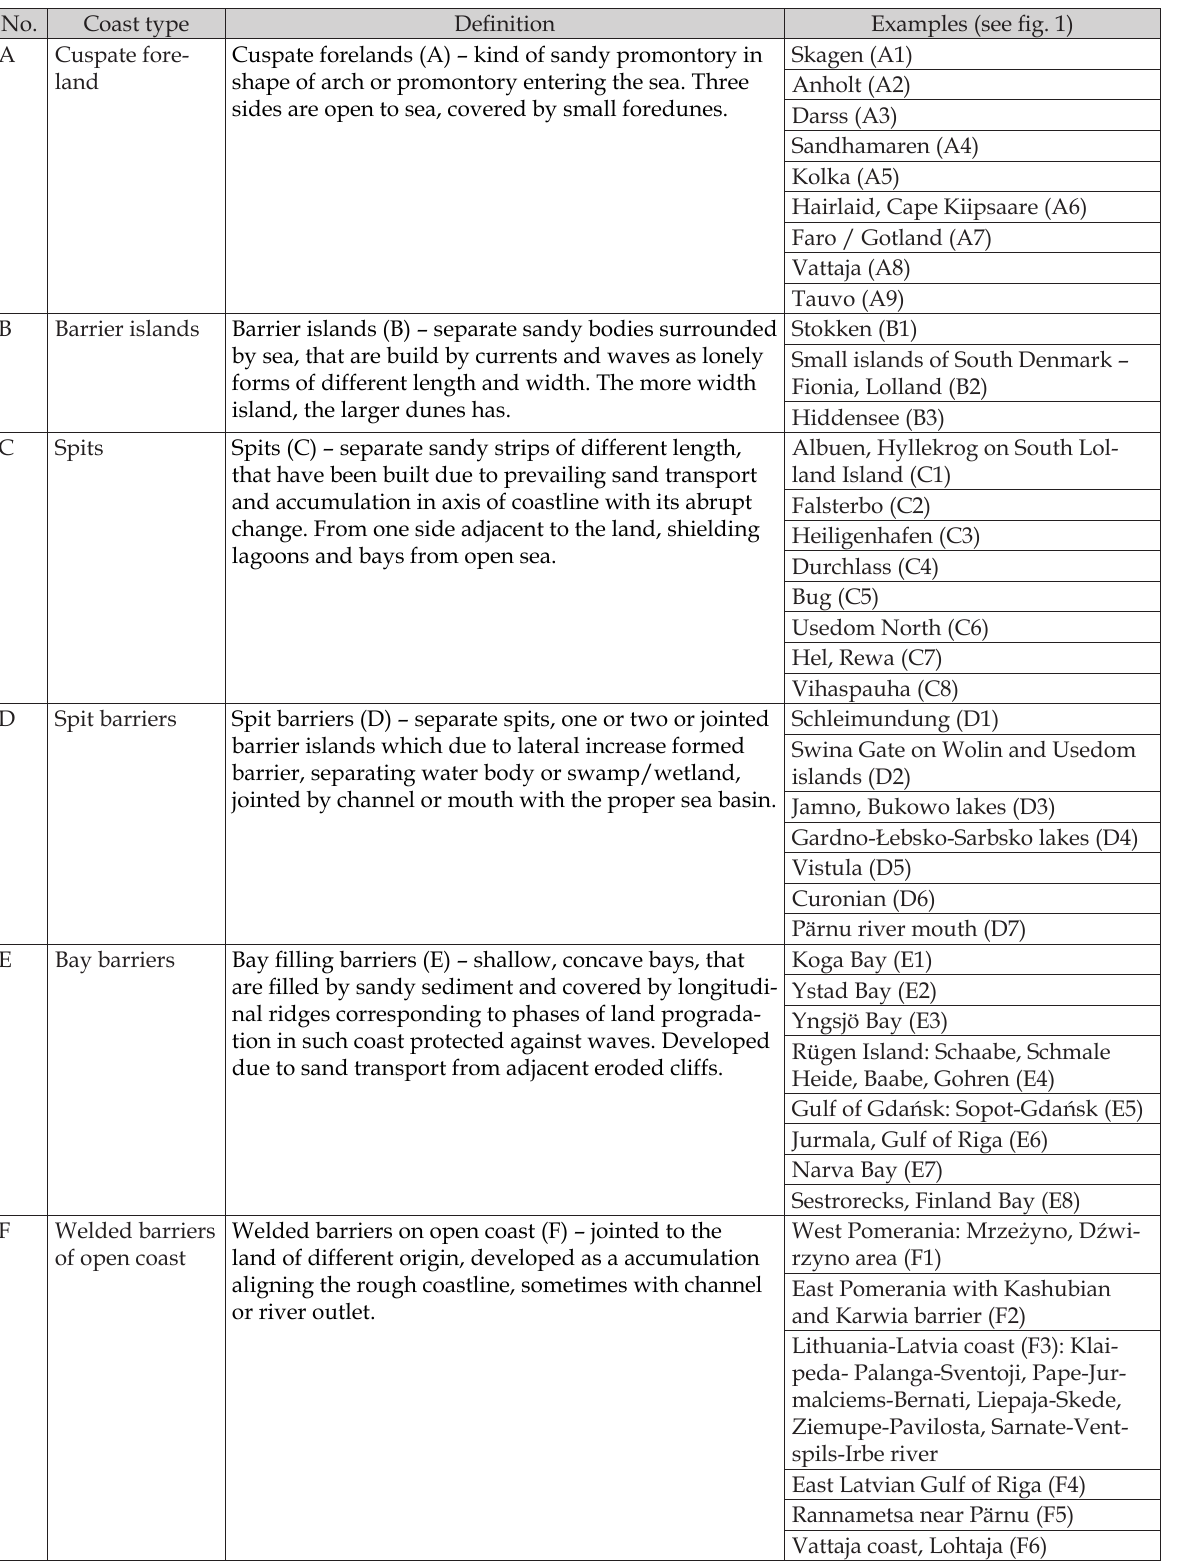
Table 1. Classification of sandy coast sandbars of the Baltic Sea (Łabuz 2017,